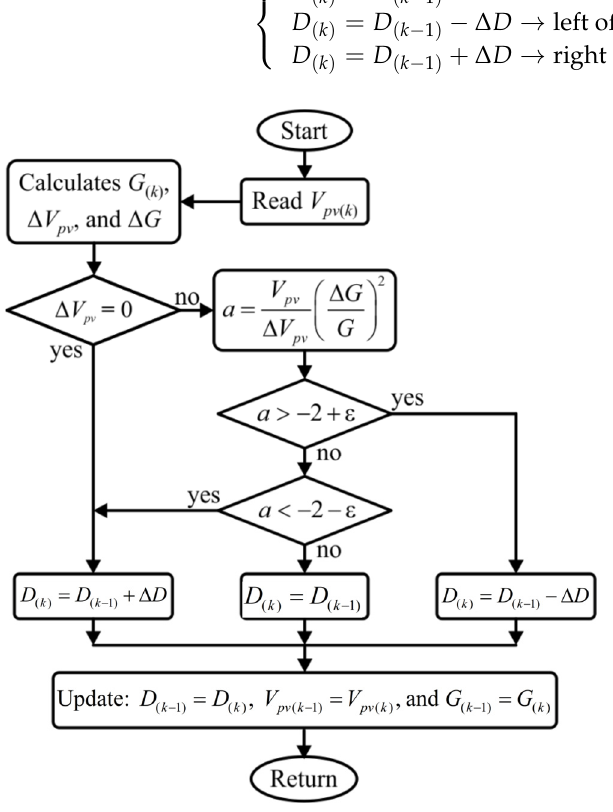
Figure 6. Flowchart of the proposed tracking algorithm.